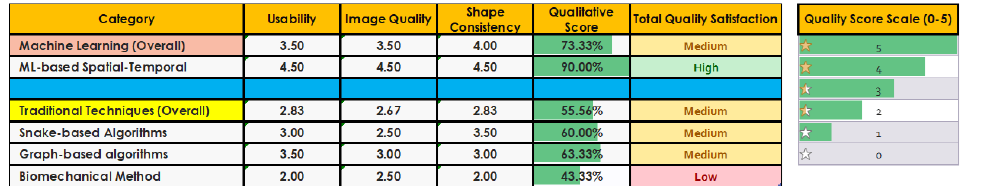
Figure 7. Quality evaluation matrix. Usability, image quality, and shape consistency are scored on a 0–5 scale (0 is the lowest and 5 is the highest). The final quality score is shown on a percentile scale and a satisfaction rate from low to high.